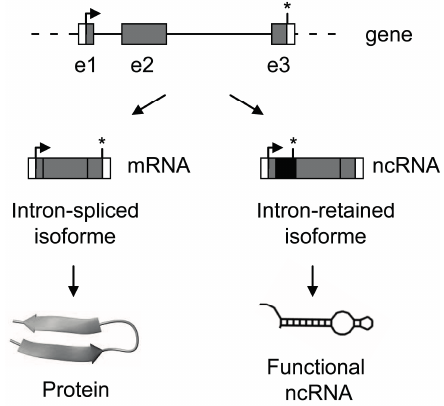
Figure 7. Both coding and non-coding RNAs can be produced by a given genetic locus. Intron-spliced isoforms are translated into protein while intron-retaining transcripts escape surveillance machineries and produce functional ncRNAs. Exons are numbered and represented by grey boxes and by thin lines. Arrow and star represent ATG and stop codon, respectively. In the mature transcript, the retained intron appears as a black box, UTR and coding sequences as white and grey boxes